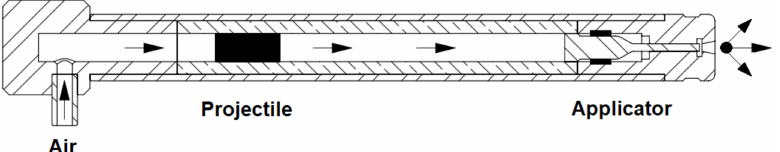
Figure 3. Schematic representation of a ballistic shockwave source, adapted from “Extracorporeal Shockwave Therapy” by L. Gerdesmeyer & L. Weil, 2007